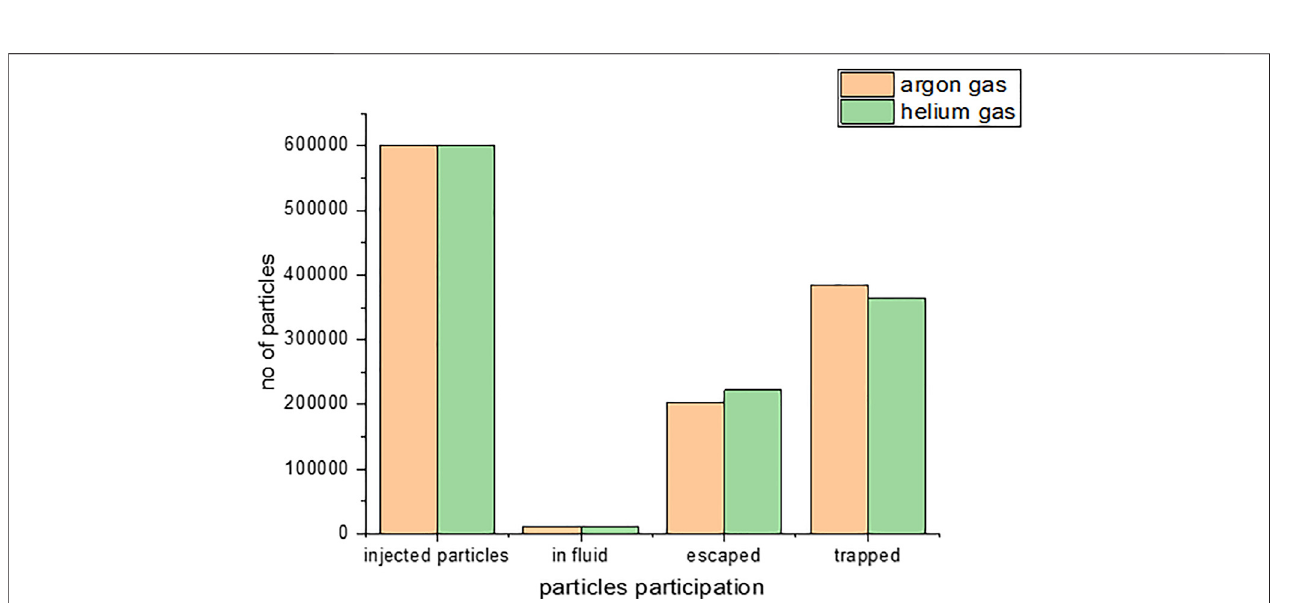
TABLE 3 | Particle participation in melt pool and focal point for various powder size distribution. Particle size (µm) Focal point from